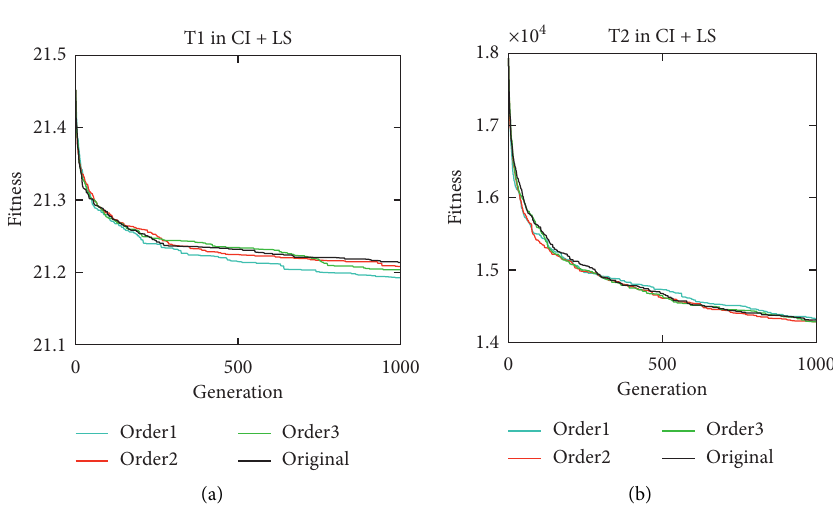
Figure 15: Convergence of MFDE for problem 3 (CI